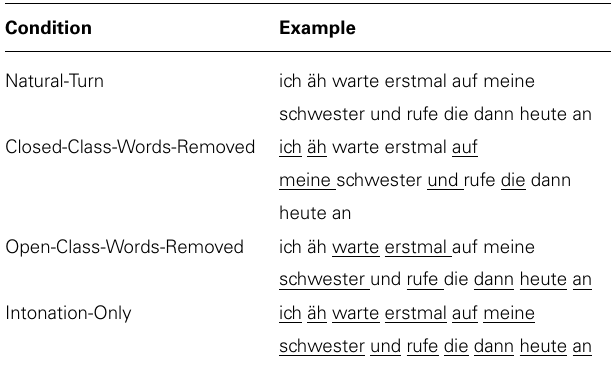
Table 4 | Example of one experimental turn in all four conditions (underlined the respective low-pass filtered